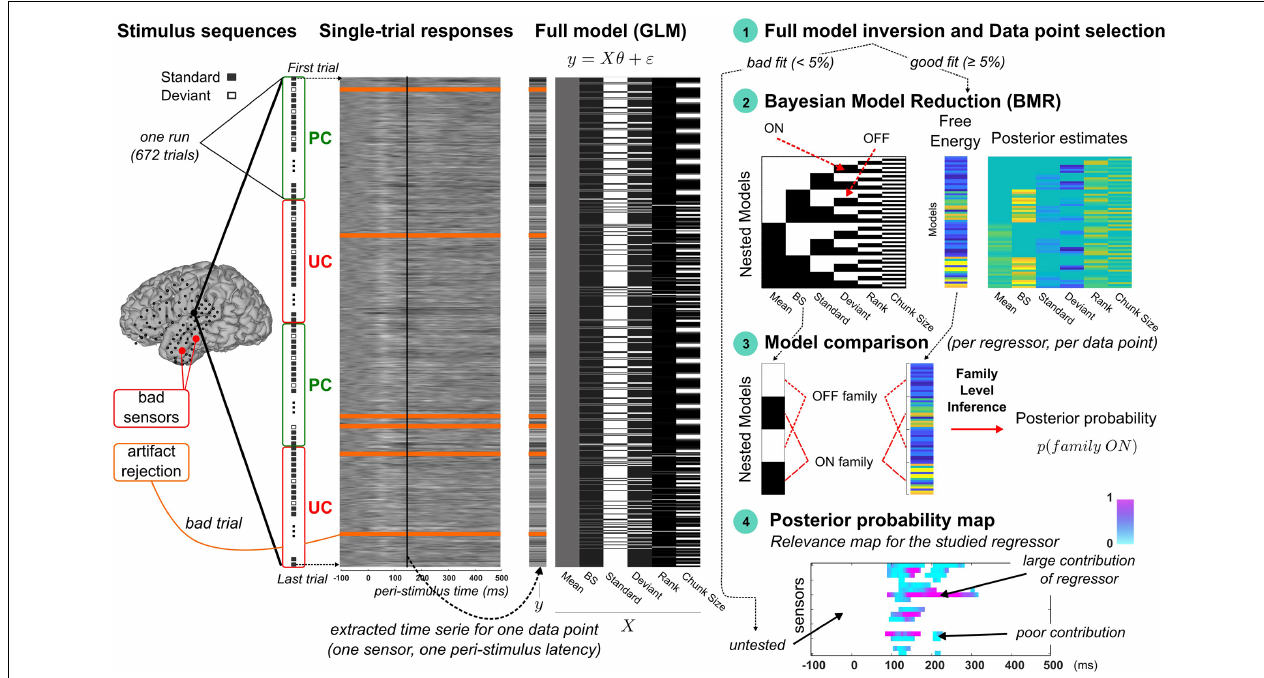
FIGURE 2 | Overview of the trial-by-trial modeling approach. From left to right . Stimulus sequences: Four illustrative runs of an experimental session are represented vertically with standard and deviant indicated by gray and white squares, respectively, and UC and PC contexts delineated by red and green rectangles, respectively. Electrocorticographic sensor overlay on a brain cortical surface (from participant P5) indicates the sensors classified as bad (red) and those retained for the modeling (black). Single-trial responses: 2D map of single-trial activity (uV) measured at the highlighted sensor on the brain surface (large black dot). Each row represents the 600 ms epoch of signal elicited by a stimulus of the oddball sequence (first and last trials are shown with dotted arrows). Bad trials (orange lines) are included in the modeling as trial order matters in dynamic processes (the related noisy signal is not accounted for). Full model (GLM): an example of design matrix (X) is provided (right) showing typical regressor trajectories (columns) over trials (rows). Data to be fitted (y) pertains to the trial-by-trial time series extracted at a particular latency (vertical black line overlaying the 2D single-activity map). Step 1, Full model fitting and selection of data points: data point is found responsive to the full model if goodness of fit is larger than 5%. In this case, the model comparison procedure (steps 2 to 4) is performed. Step 2, Bayesian model reduction: left panel (model space): each model (row) corresponds to a nested version of the full model obtained by switching ON (black) and OFF (white) the different regressors. Bottom row represents the full model (all regressors are ON). Right panel: BMR is applied to each nested model to derive the free energy and posterior estimates of model parameters. Step 3, Model comparison: for each regressor, two families are compared using family-level inference (Penny et al., 2010). The ON family (indicated here for the dynamic regressor, with BS denoting the Bayesian Surprise) includes all the ON models (black) with associated free energies as indicated with the dotted red lines. The OFF family is defined similarly based on the OFF models (white). Step 4, Posterior probability map: Posterior probability of the ON family is then computed at each responsive data point to derive a spatio-temporal map of the regressor’s relevance. At each sensor ( y -axis) and each peri-stimulus latency ( x -axis), color intensity (from blue to pink) reflect the posterior probability (in [0, 1]). White points corresponds to untested data points due to an unreliable fitting of the full model (unresponsive data point). All maps in this figure are shown with arbitrary color